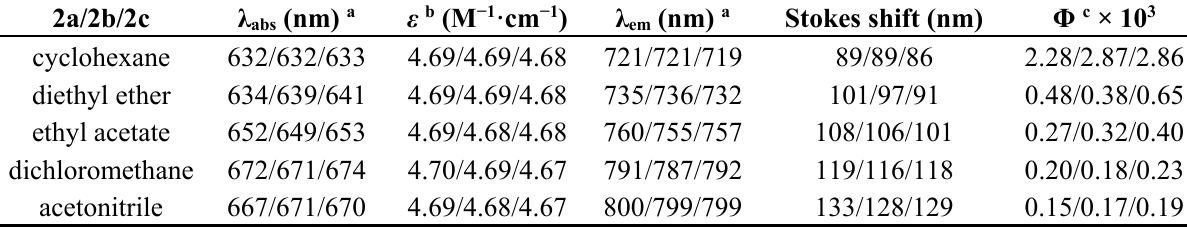
Table 2. Summary of optical absorption and emission properties of 2a – 2c in various solvents.